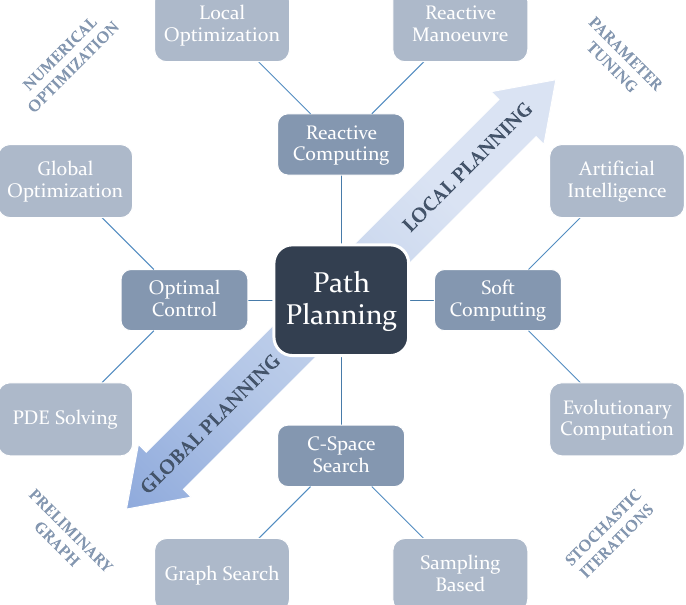
Figure 1. Schematic showing the proposed classification of existing path planning approaches. There are four main categories, each of them containing two subcategories. Two adjacent subcategories from different categories have features in common. The schematic also indicates how some subcategories are more inclined towards either Global Planning or Local Planning